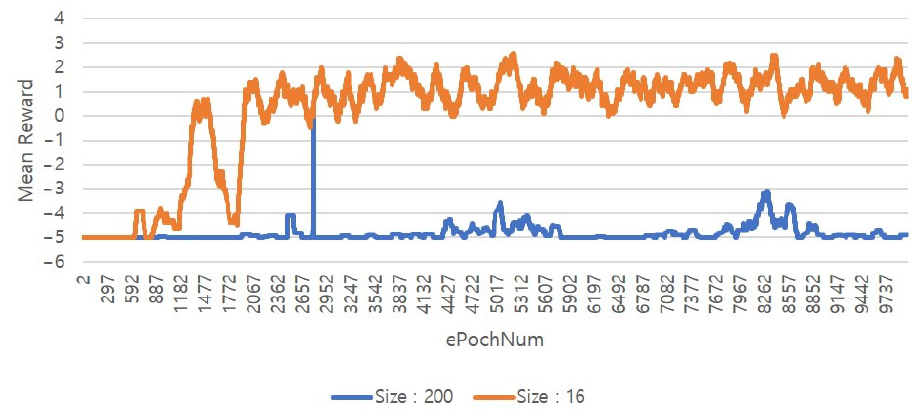
Figure 13. Reward values of a DQN algorithm.